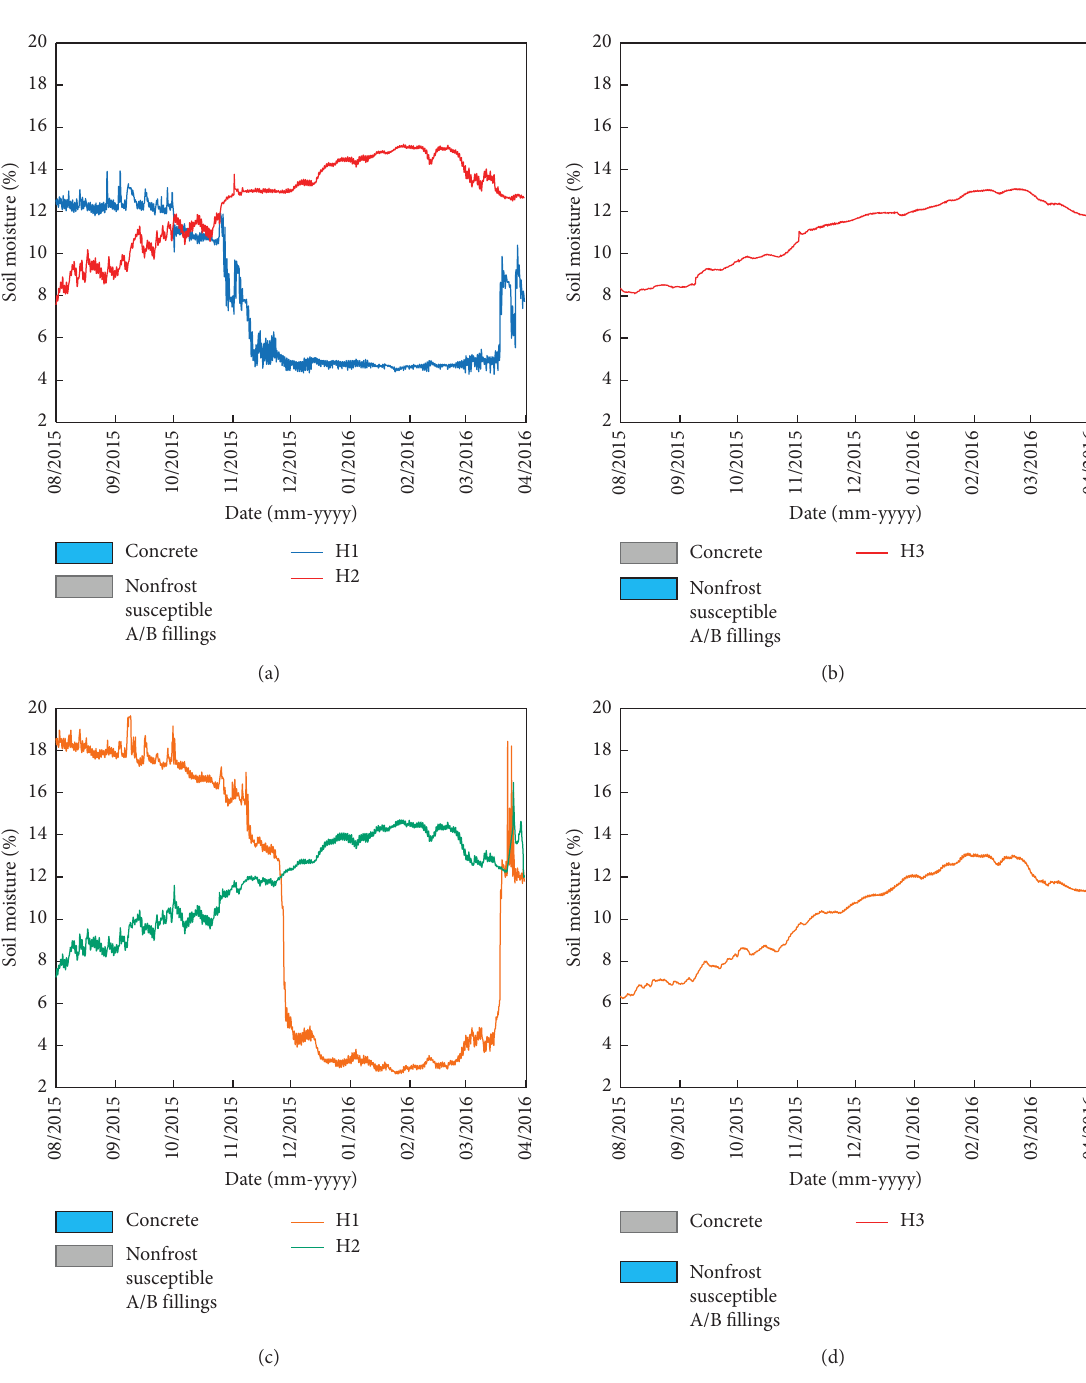
Figure 2: Variations in moisture content were measured at three depths in two sections from August 2015 to March 2016. Note. H1 to H3 represents depth of 0.2, 0.5, and 1.0m, respectively. (a-b) K 2020+024 section. (c-d) K 2028+746